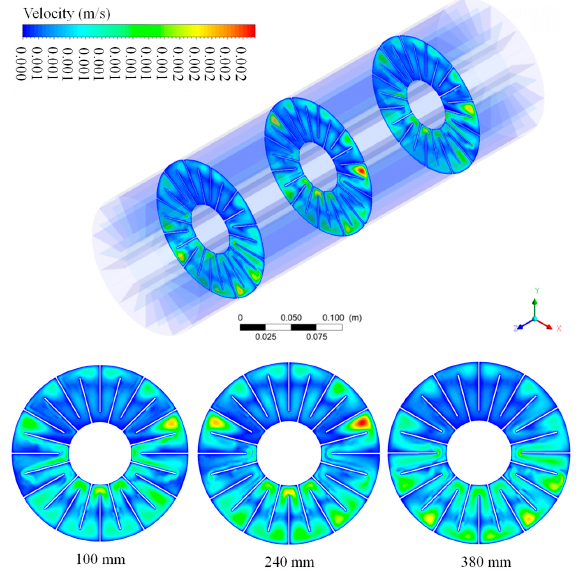
Energies 2023 , 16 , x FOR PEER REVIEW Figure 22. Distribution of velocities in the PCM domain for 90% (t = 4942 s) of its volume in a liquid state.